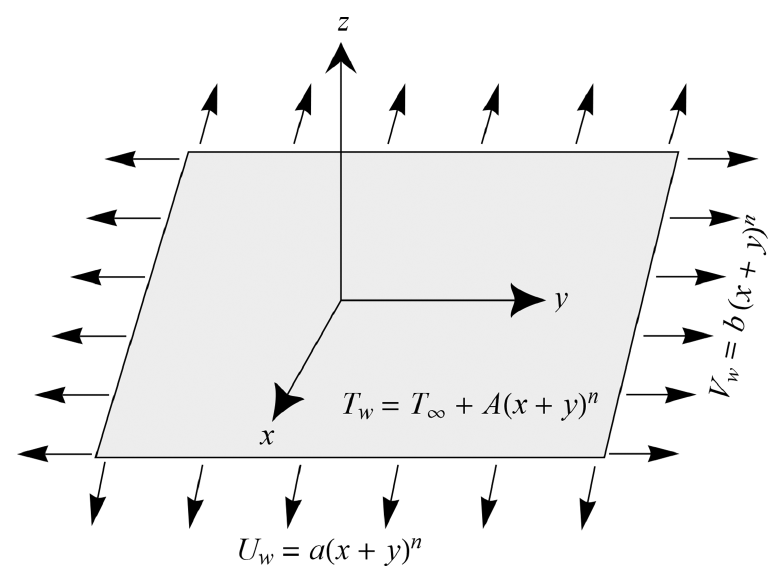
Figure 1. Physical configuration and coordinate system.